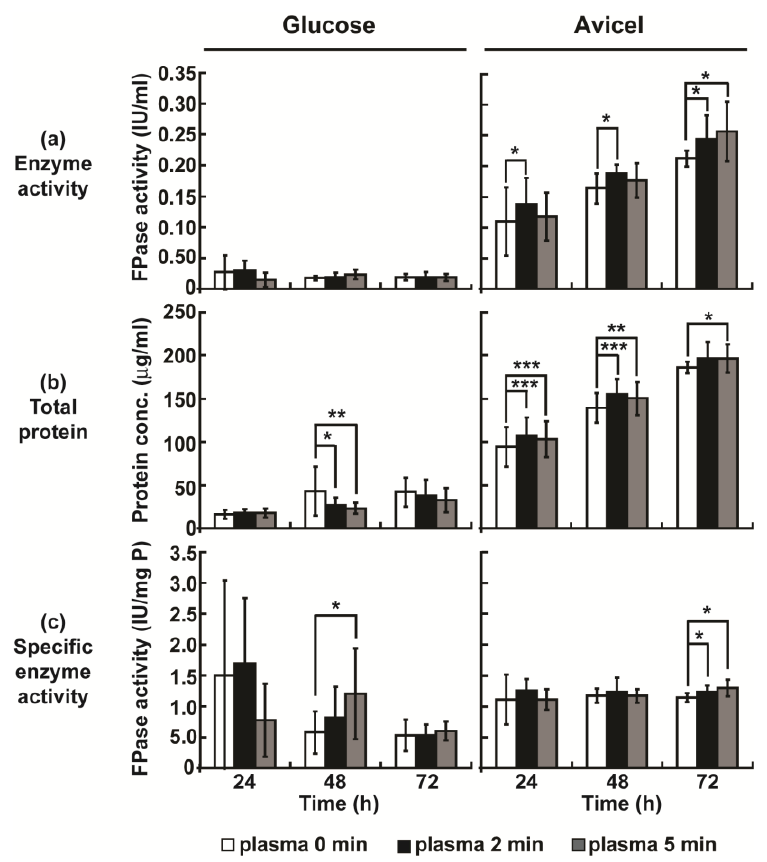
Figure 2. Activities of cellulolytic enzymes measured in media. Media were harvested at 24, 48, and 72 h after plasma treatment. ( a ) Filter paper enzyme (FPase) activity (total activity of cellulolytic enzymes) in media. ( b ) Total protein concentration in media. ( c ) Specific enzyme activity. Each value represents the mean of 9 – 12 replicate measurements: * p < 0.05, ** p < 0.01, *** p < 0.001.